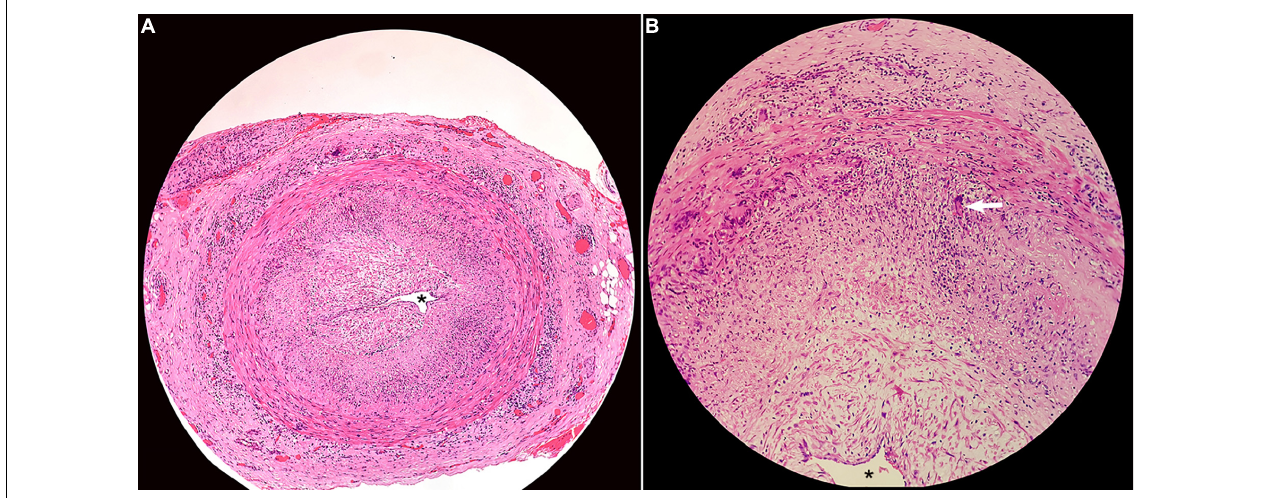
FIGURE 5 | Histopathology of superficial temporal artery biopsy showing (A) transmural inflammation of the artery wall, intimal thickening, and near obliteration of the artery lumen (asterisk; H&E × 40); (B) multinuclear giant cell (arrow; H&E ×